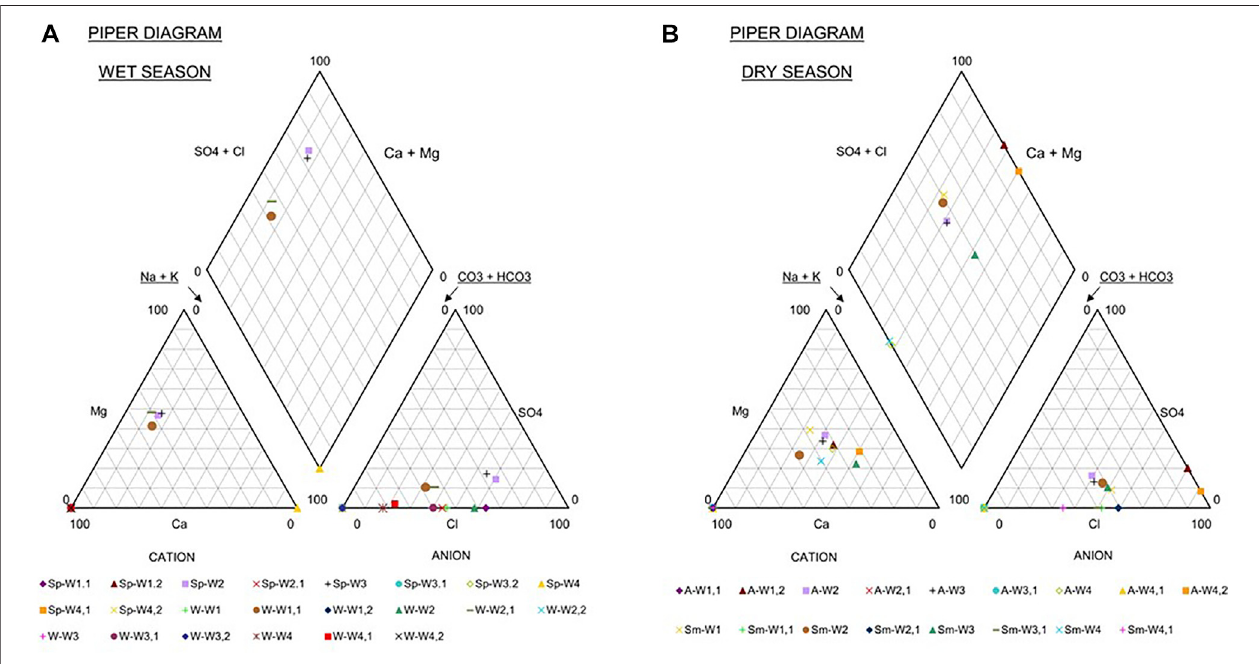
FIGURE 3 | Seasonal hydrochemistry from the community-based water monitoring through the Piper diagram (A) during the wet season that included winter and spring (B) dry season summer and autumn.